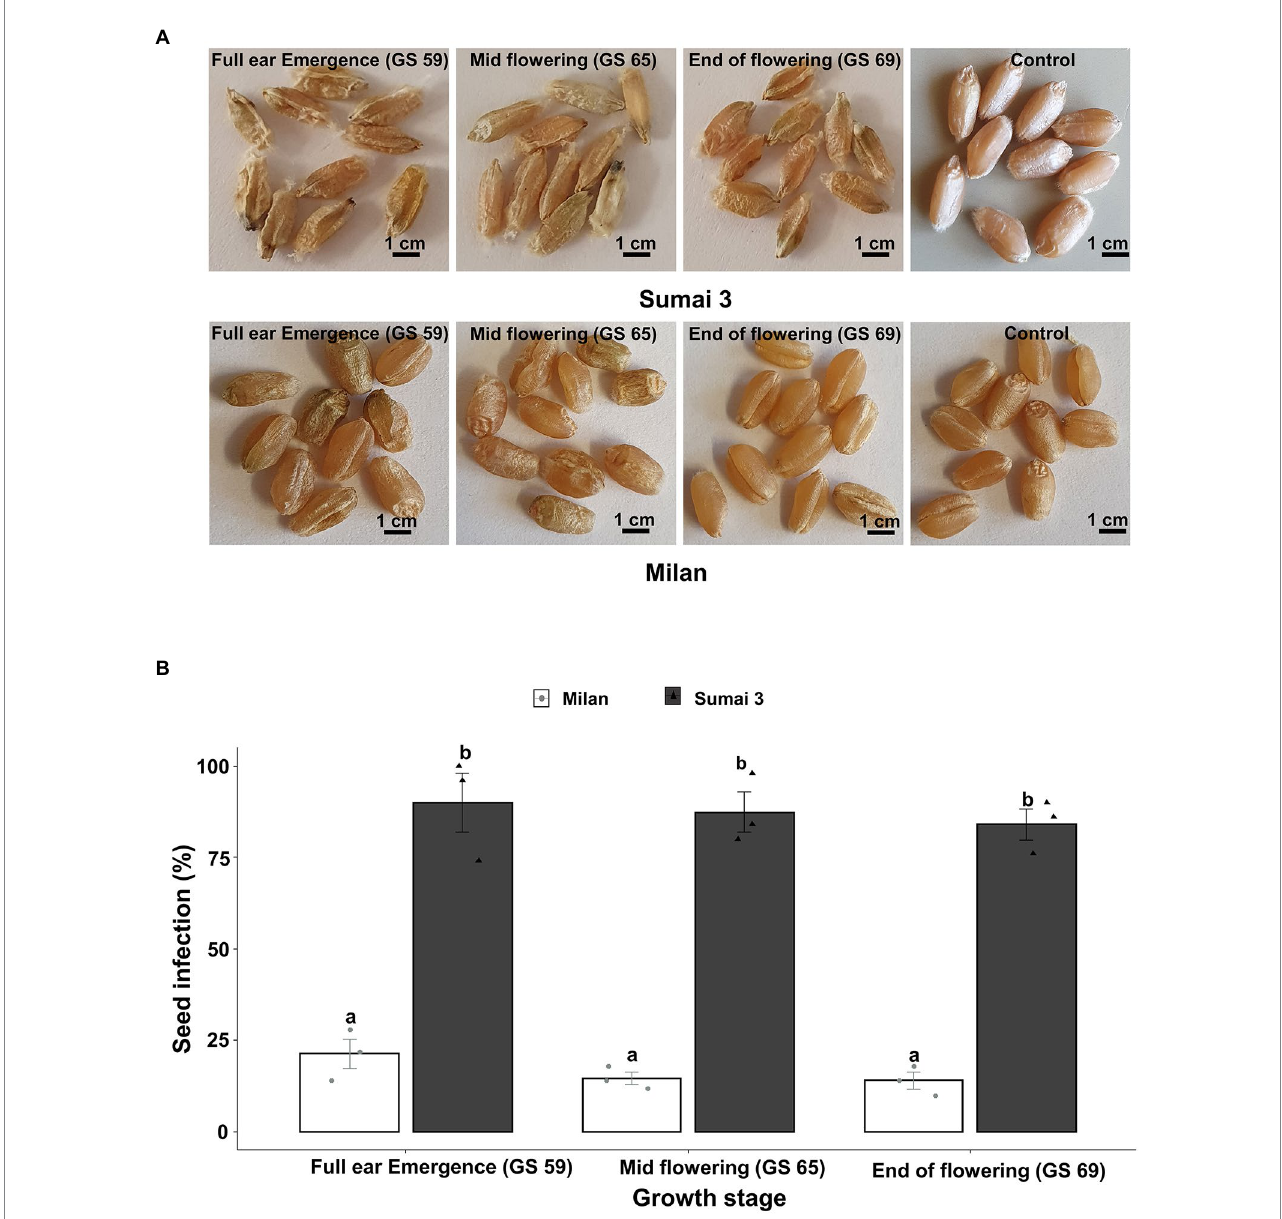
FIGURE 1 Effect of MoT inoculation of wheat ears on MoT seed infection of Sumai 3 and Milan in greenhouse conditions. (A) Mature seeds of Sumai 3 and Milan were collected from ears inoculated at three different ear maturity stages (GS 59, full ear emergence; GS 65, mid flowering; and GS 69, end of flowering); (B) Seed infection with MoT in Sumai 3 and Milan cultivars assessed by plating assay under greenhouse conditions. Surface sterilized seeds were incubated on PDA at 25 ° C for 5 days. The mean (±standard error) of seed infection (%) of each ear inoculation time point is represented by each bar. ANOVA with Tukey test was performed, and treatments with the same letters at the cultivar level were not significantly different ( n = 3; one replication contained 30 seeds of each cultivar at each inoculation time point; p = 0.05). Each data point represents one replicate consisting of 30 randomly selected